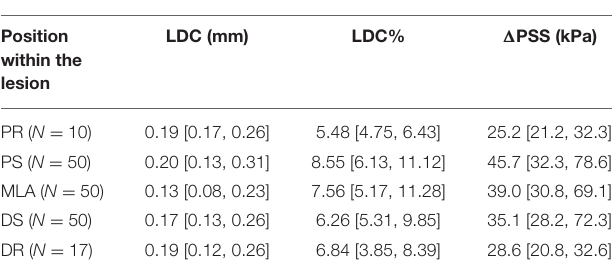
TABLE 5 | Biomechanical